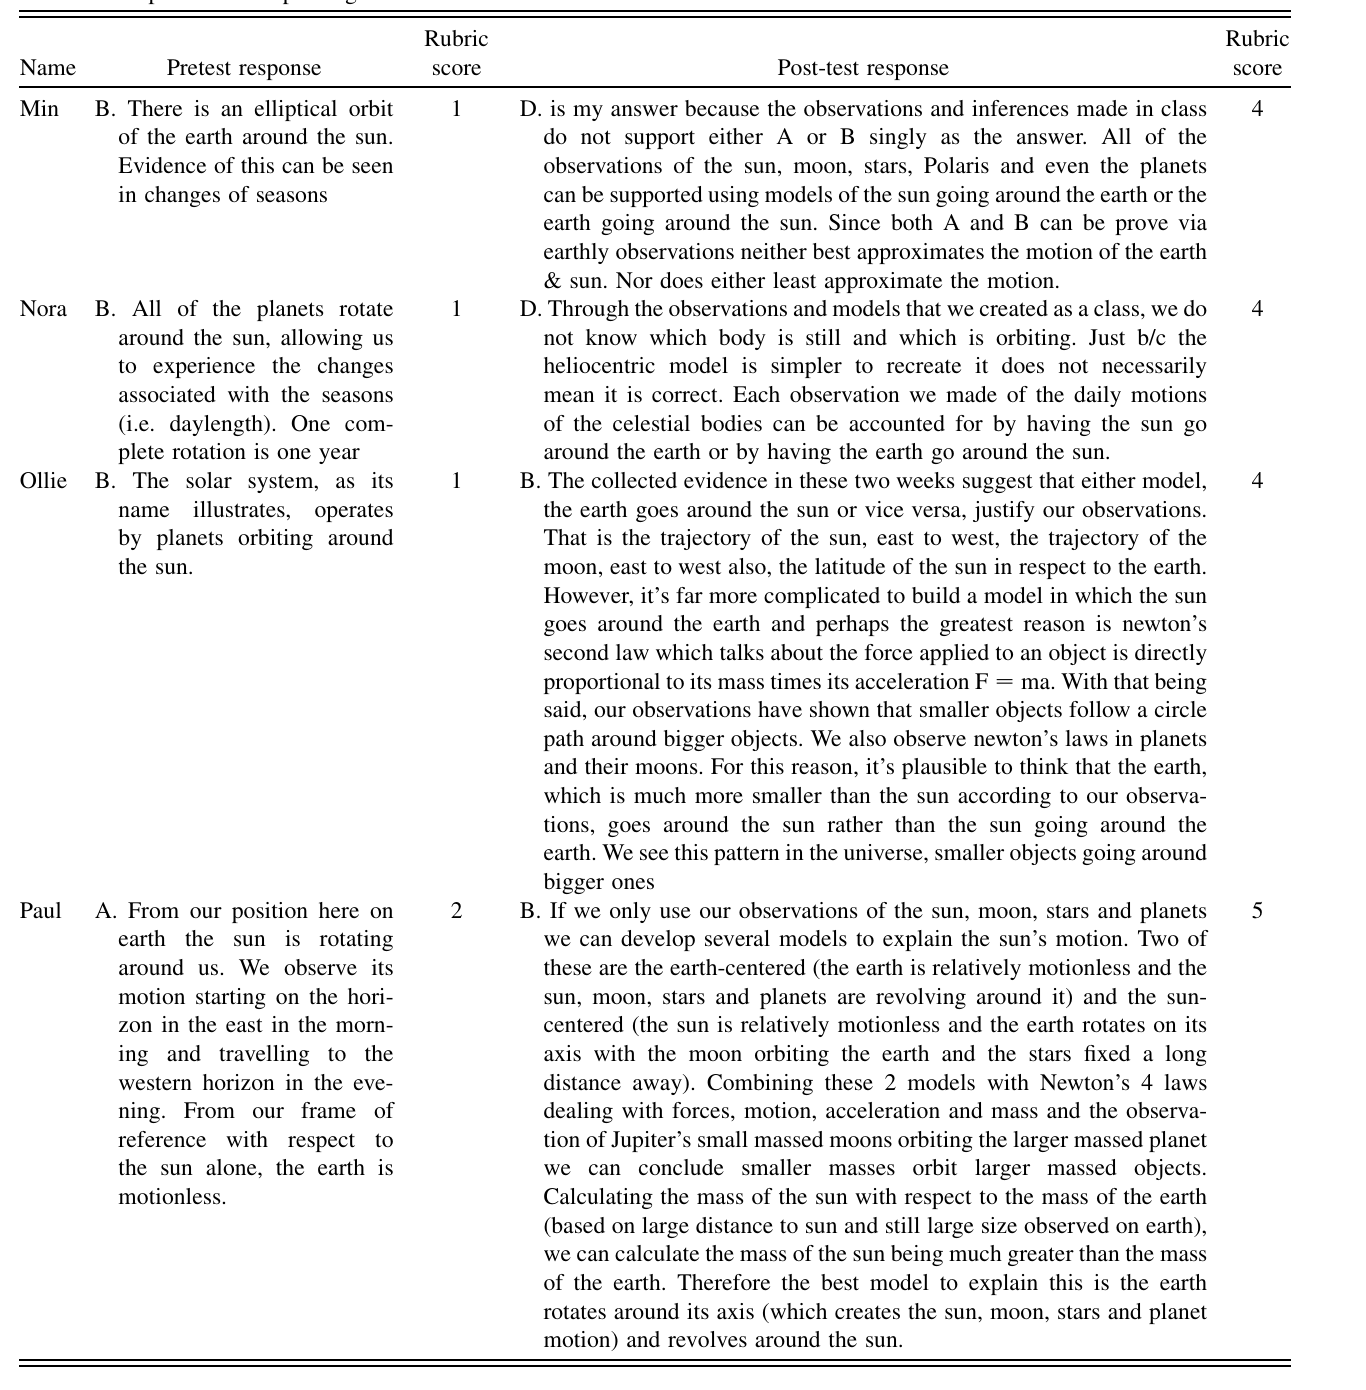
TABLE V. Sample full verbatim matched responses to ‘‘proper and complete scientific argument’’ question in Fig. 1. A, B, C, and D refer to multiple-choice response